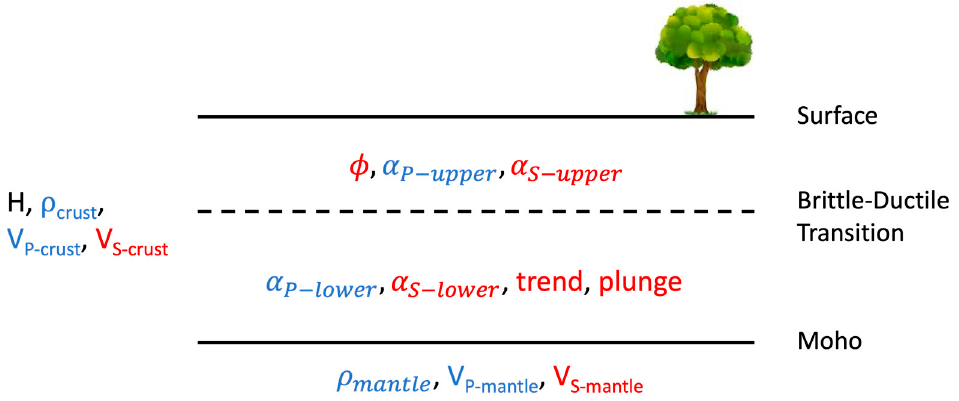
Figure 2. The three-layered model used for the forward modeling. Note that seven of the parameters were either derived from the other parameters (blue) or fixed based on a reference (black). The red parameters are the free parameters. H = crustal thickness. Φ = fast polarization direction. 𝛼 p and 𝛼 s = the anisotropy percentages of the P - and S -waves; one set of values for the upper crust and a second for the lower crust. ρ = the crustal density and the mantle density. Vp and vs. = the P - and S - wave velocity; one set for the crust, one for the mantle. Table 1. Ranges of values searched for each free parameter.